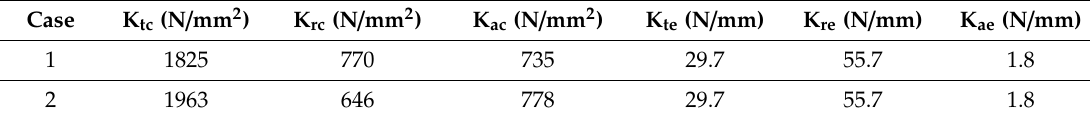
Table 4. The cutter parameters and the milling process parameters.